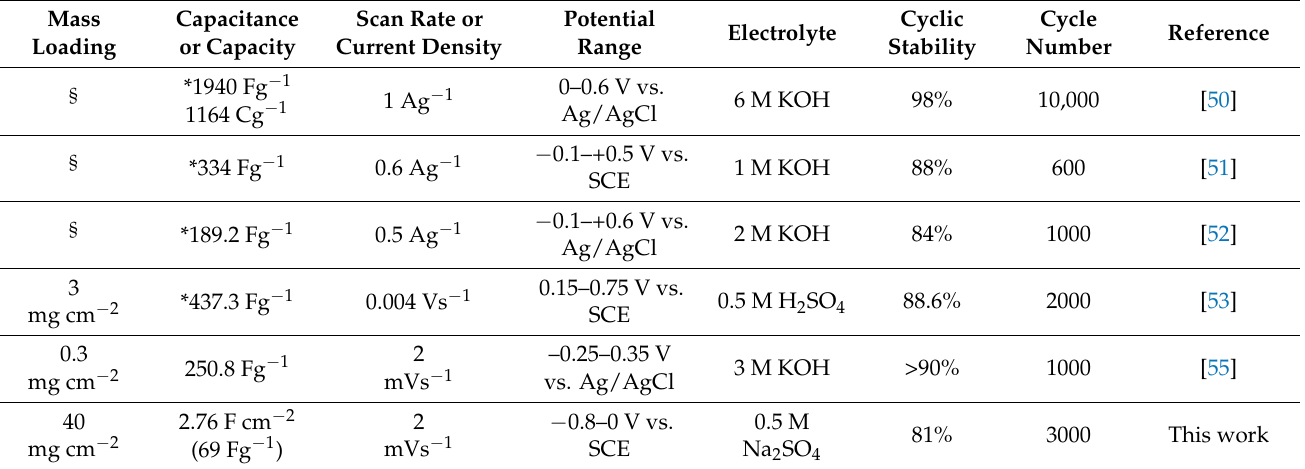
Table 1. Properties of CuFe 2 O 4